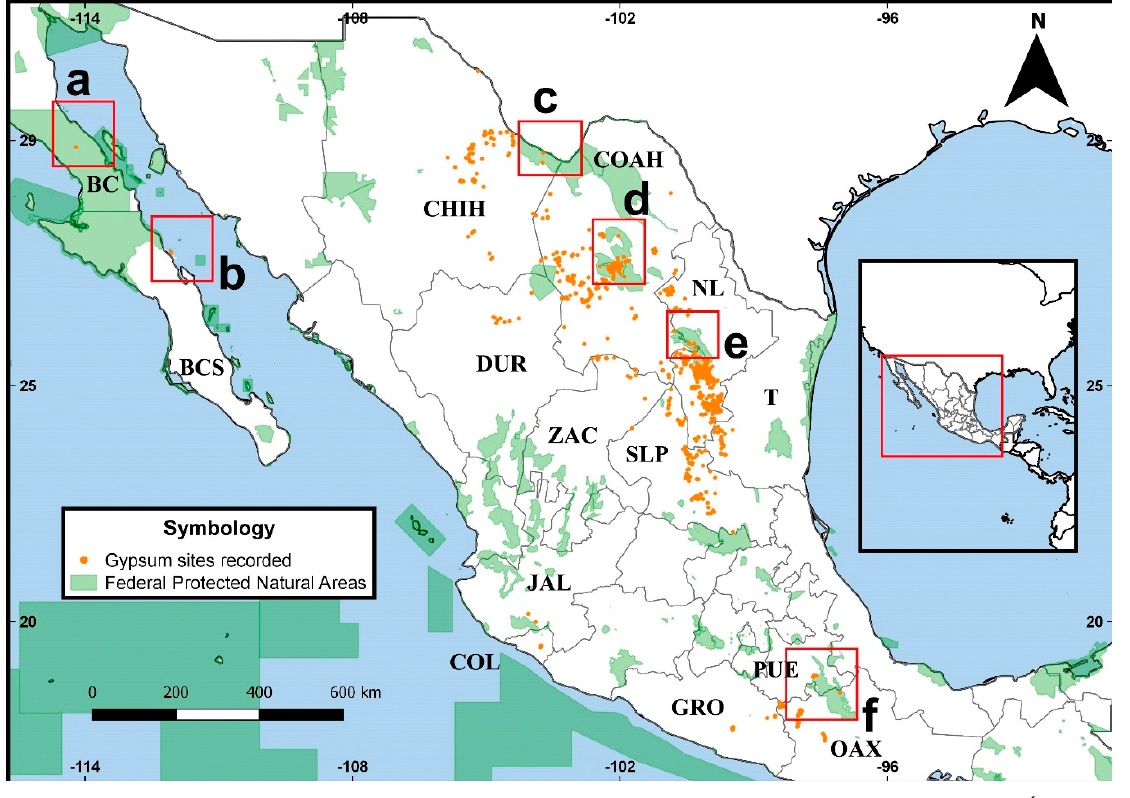
Figure 5. Protected Natural Areas (PNAs) of Mexico with gypsum records. ( a ) Área de Protección de Flora y Fauna (APFF) Valle de Los Cirios, ( b ) APFF Islas del Golfo de California, ( c ) APFF Cañón de Santa Elena, ( d ) APFF Cuatro Ciénegas and Área de Protección de los Recursos Naturales